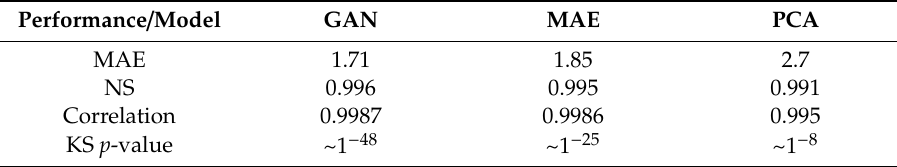
Table 3. Performance comparison of di ff erent downscaling